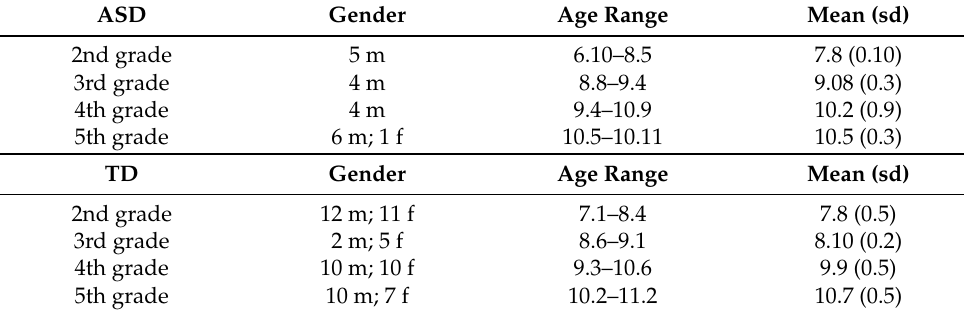
Table 1. Sample details for each group per grade levels.